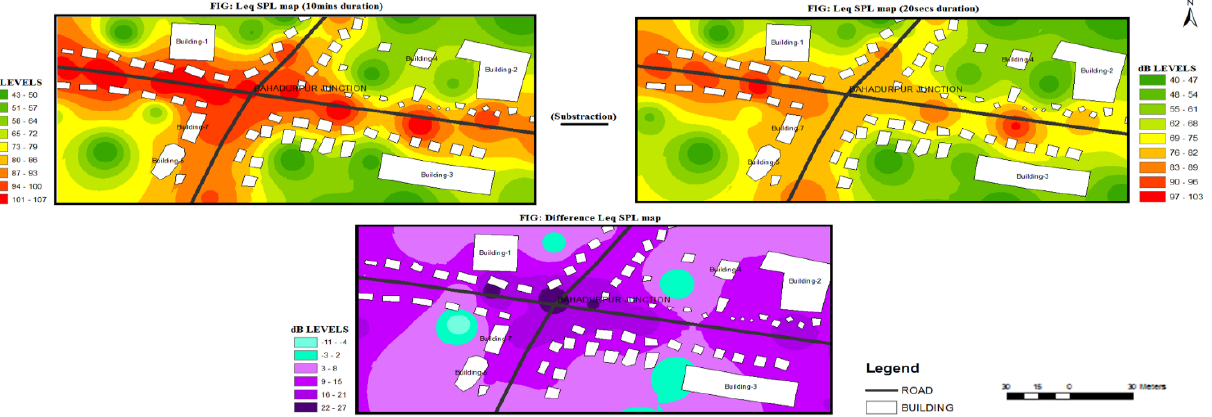
Acoustics 2022 , 4 FOR PEER REVIEW Figure 15. Long vs short noise sampling duration based noise prediction and their difference at M1